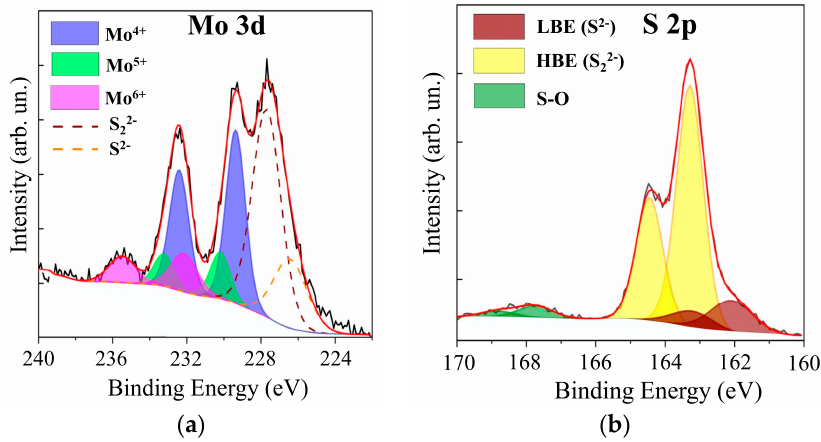
Figure 12. The XPS ( a ) Mo 3d and ( b ) S 2p spectra for a MoS 3.2 film obtained by RPLD at an H 2 S pressure of 18 Pa and post-treated in acidic solution at a potential of 2 V.